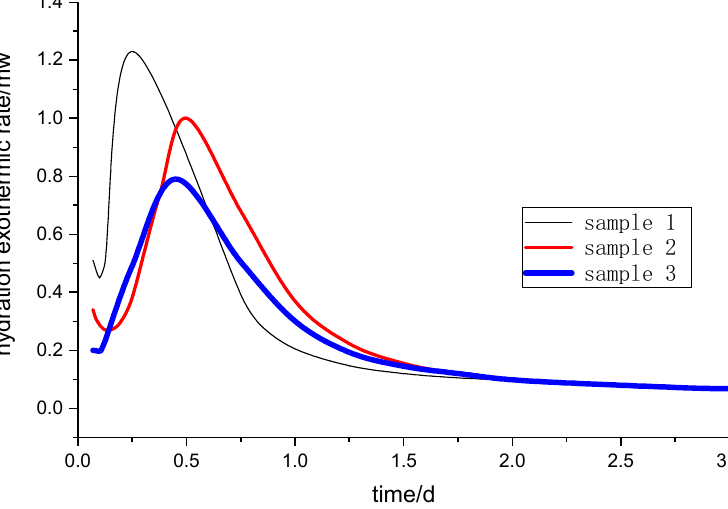
Figure 2. Hydration exothermic rate curve of different samples. 2.1.2. Chemically Bound Water Analyzes